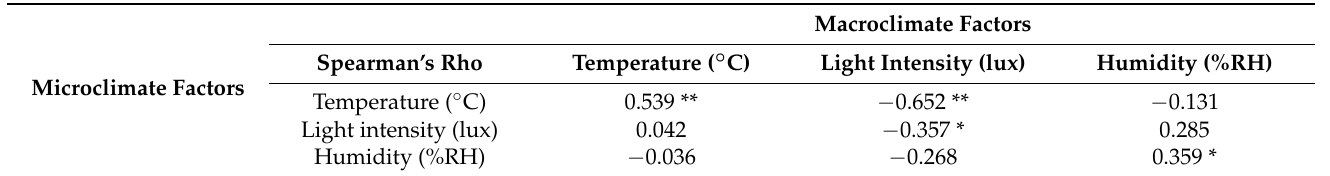
Table 4. Strength of correlations and their significance levels based on Spearman’s correlation analysis between macroclimate and microclimate factors at Perlis